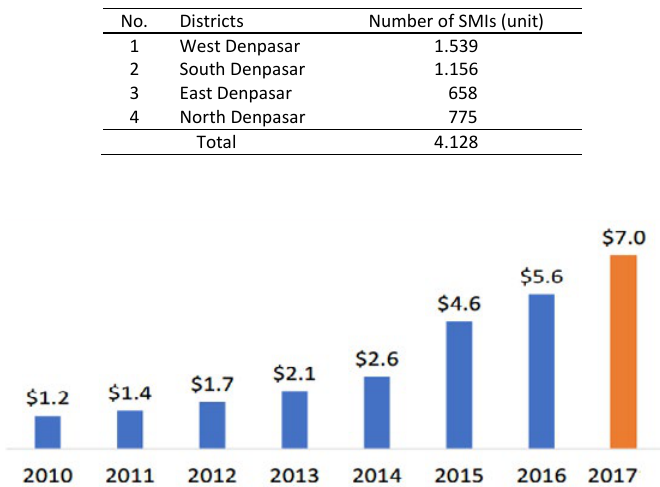
Fig. 1. Sales Using ecommerce in Indonesia (GER, Fig. 1: Sales Using ecommerce in Indonesia (GER, 2017)